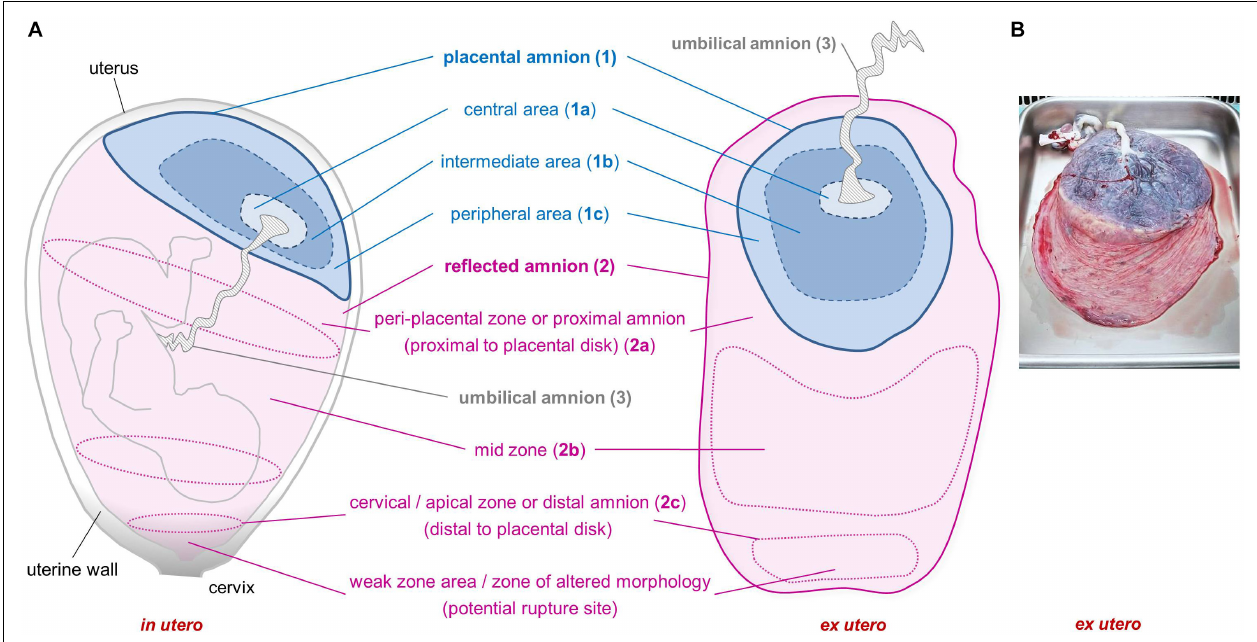
FIGURE 1 | Sub-regions of the human amniotic membrane. Schematic of placenta and amniotic membrane in utero and ex utero (A) . Image of placenta and fetal membranes before preparation of amniotic membrane (B) . Placental amnion (1) (blue; covers the placenta), reflected amnion (2) (pink; lines the uterine wall), and umbilical amnion (3) (gray; covers the umbilical cord). Placental amnion (1) can be divided into a central area (1a), which is closest to the umbilical cord; an intermediate area (1b); and a peripheral area (1c) at the edge of the placental disk. Reflected amnion (2) is further divided into a peri-placental zone or proximal amnion (2a), which is the area closest to the placental disk; a mid-zone (2b); and a cervical/apical zone or distal amnion (2c), the area farthest from the placental disk. The weak zone (or zone of altered morphology) is located in the cervical zone and is the zone where the rupture of the membranes occurs before the onset of